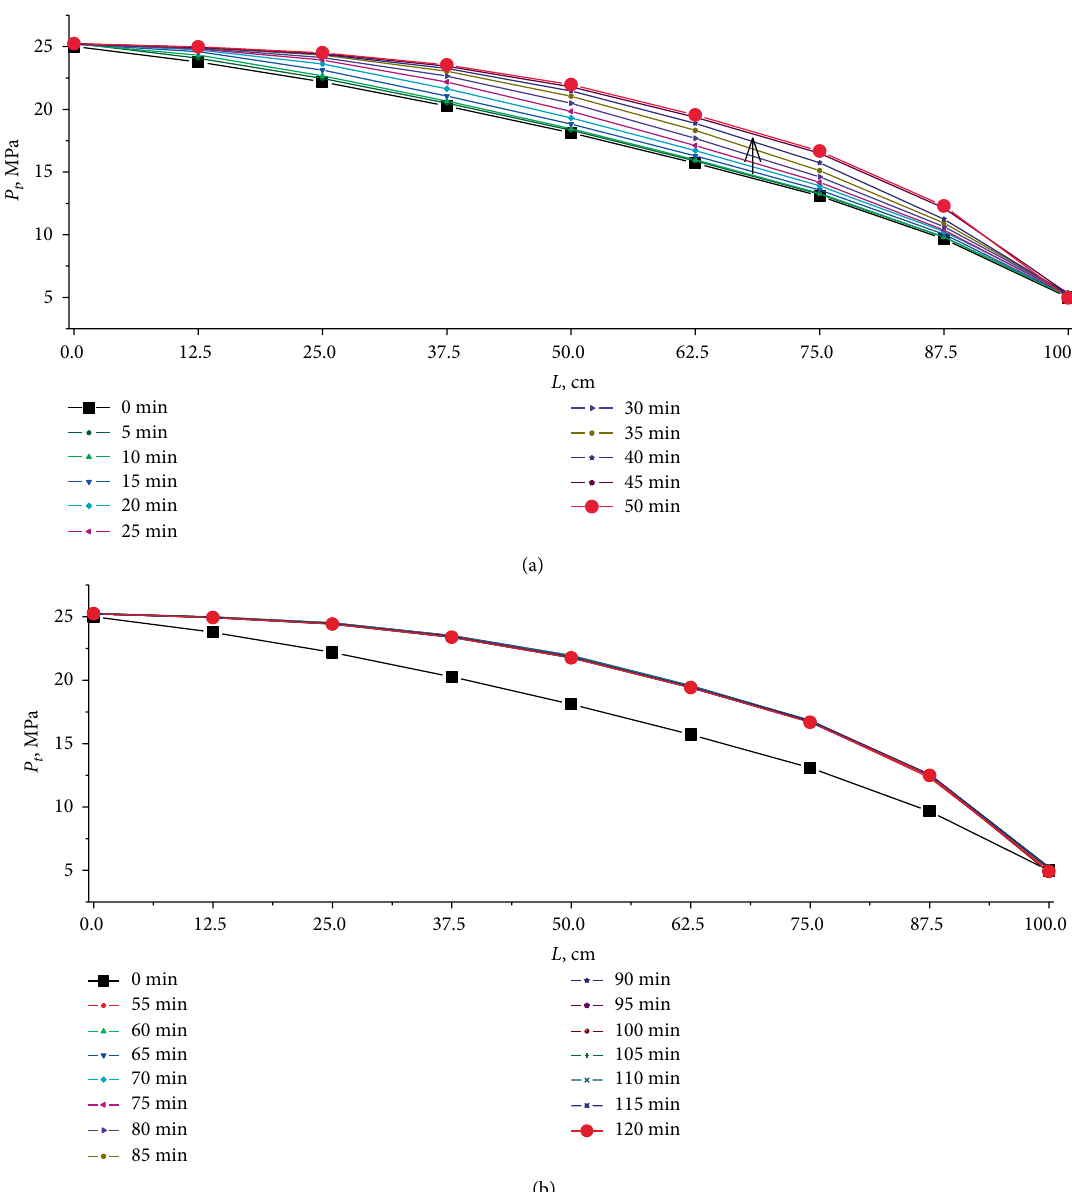
flooding: (a) 0–50 min and (b) 55–120 2